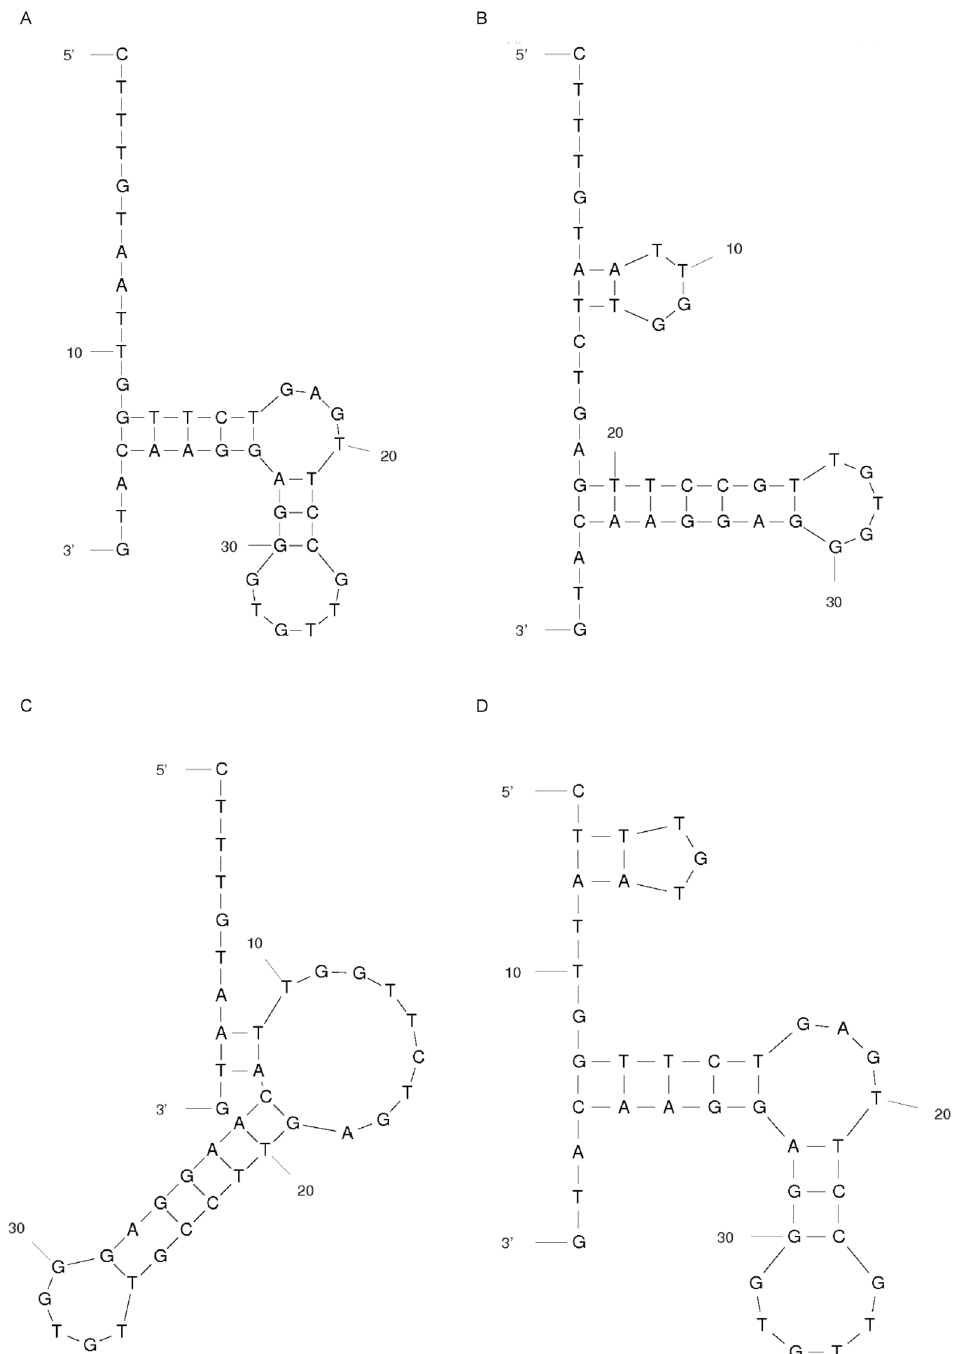
Figure 6. AR aptamer putative secondary structure analysis. The ( A–D ) structures were modeled using mfold web